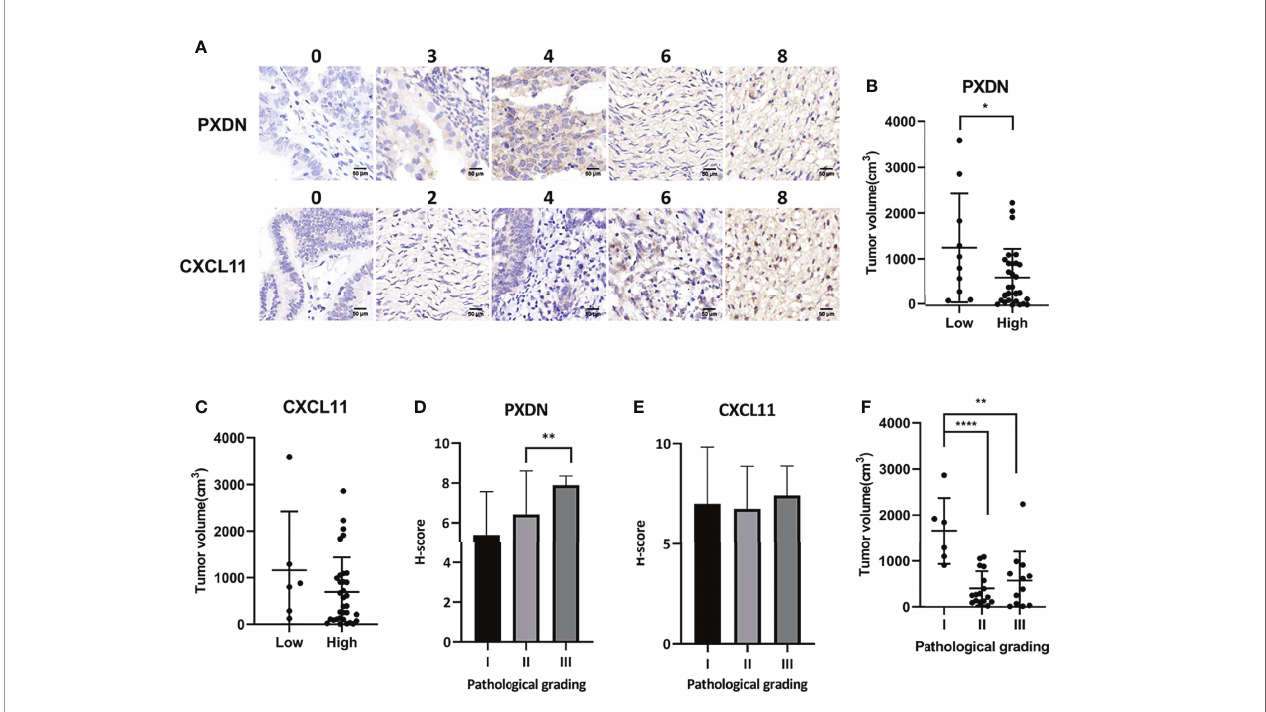
FIGURE 8 | Association between the expression of CXCL11 and PXDN and the progression of OV. (A) We divided two subgroups in each gene: PXDN high group (n=51); PXDN low group(n=14); CXCL11 high group(n=54); CXCL11 low group(n=11). Results shows the staining corresponding to different scores. (B) The relationship between tumor size and the expression of PXDN. (C) The relationship between tumor size and the expression of CXCL11. (D) The correlation between H-score and Pathological grade of PXDN. (E) The correlation between H-score and Pathological grade of CXCL11. (F) There was an inverse correlation between tumor size and pathological grade. Error bars, SD. *P < 0.05, **P < 0.01, ****P <